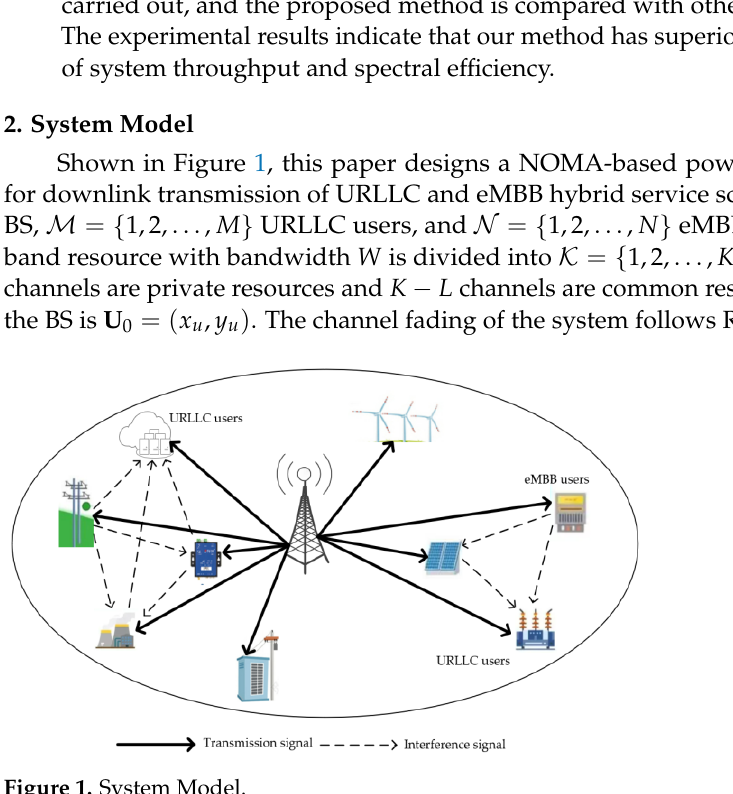
Figure 1. System